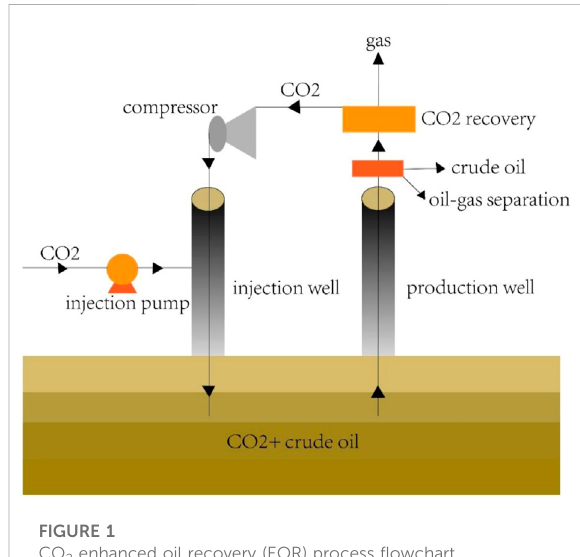
FIGURE 1 CO 2 enhanced oil recovery (EOR) process fl